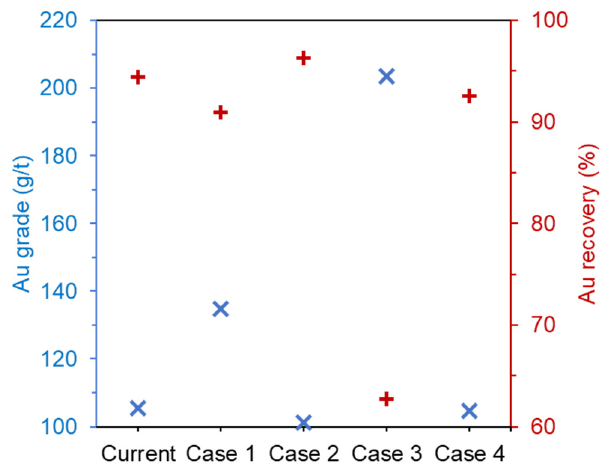
Figure 9. Simulated mass balance of current process for processing gold ore.